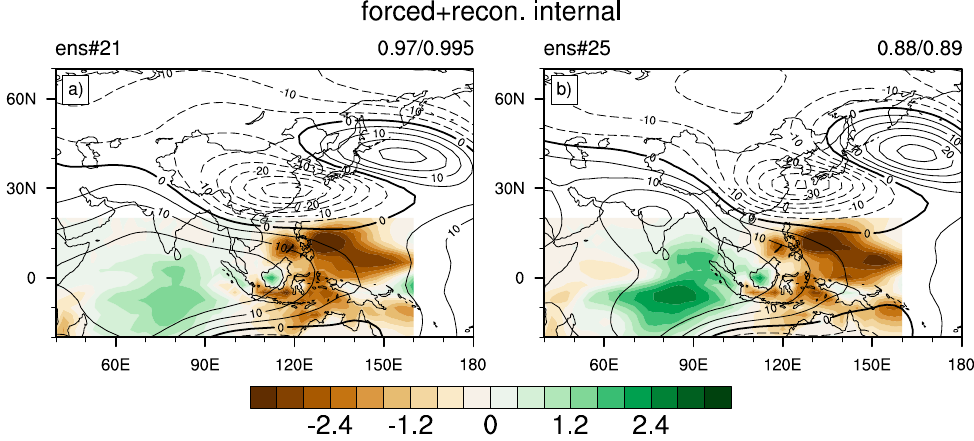
Figure 9. Sum of SST-forced components and reconstructed internal components in runs 21 and 25. The numbers in top-right corner of each panel indicate pattern correlation with the total anomalies for rainfall and Z200, respectively.